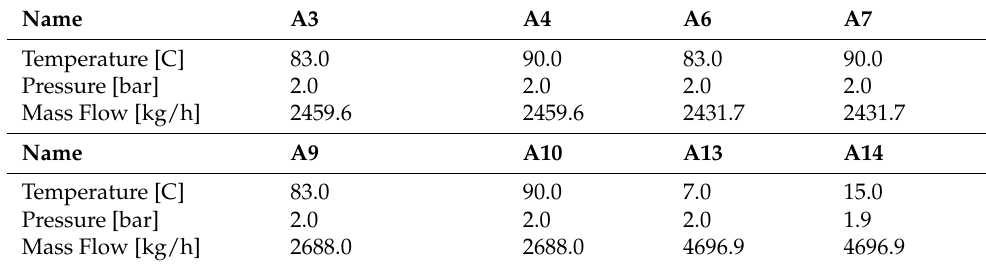
Table A8. States of the water flows in